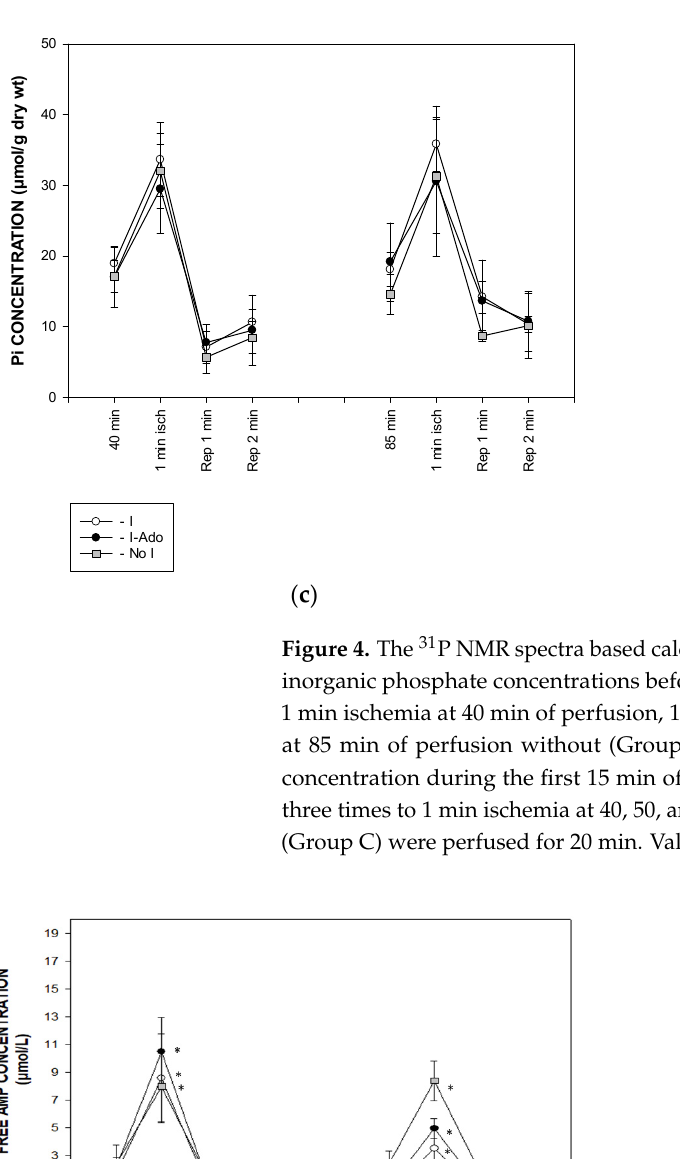
Figure 6. Oxygen consumption rate (OCR) in the mitochondria of the rat heart subjected to repeated 1 min and 10 min ischemic intervals. Values shown are initial concentrations (after a 20 min perfu- sion period, Group C) or at the end of protocols without 10 min ischemia (Group No I), with 10 min ischemia (Group I), and with 10 min ischemia plus infusion of 30 µM adenosine (Group I-Ado)